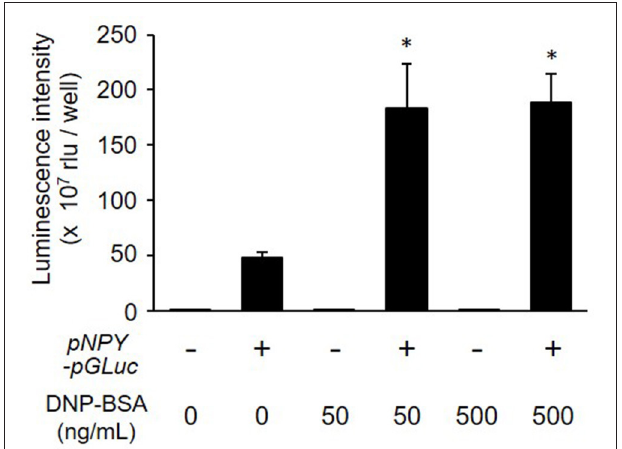
FIGURE 3 | Release of NPY-GLase from RBL-NPY-GLase cells by antigen stimulation. Luminescence activities of NPY-GLase released from the cells stimulated with DNP-BSA for 30min were compared between wild-type cells (open bars) and RBL-NPY-GLase cells (closed bars). Data represent the means ± SD ( n = 3, * p < 0.05 vs. without